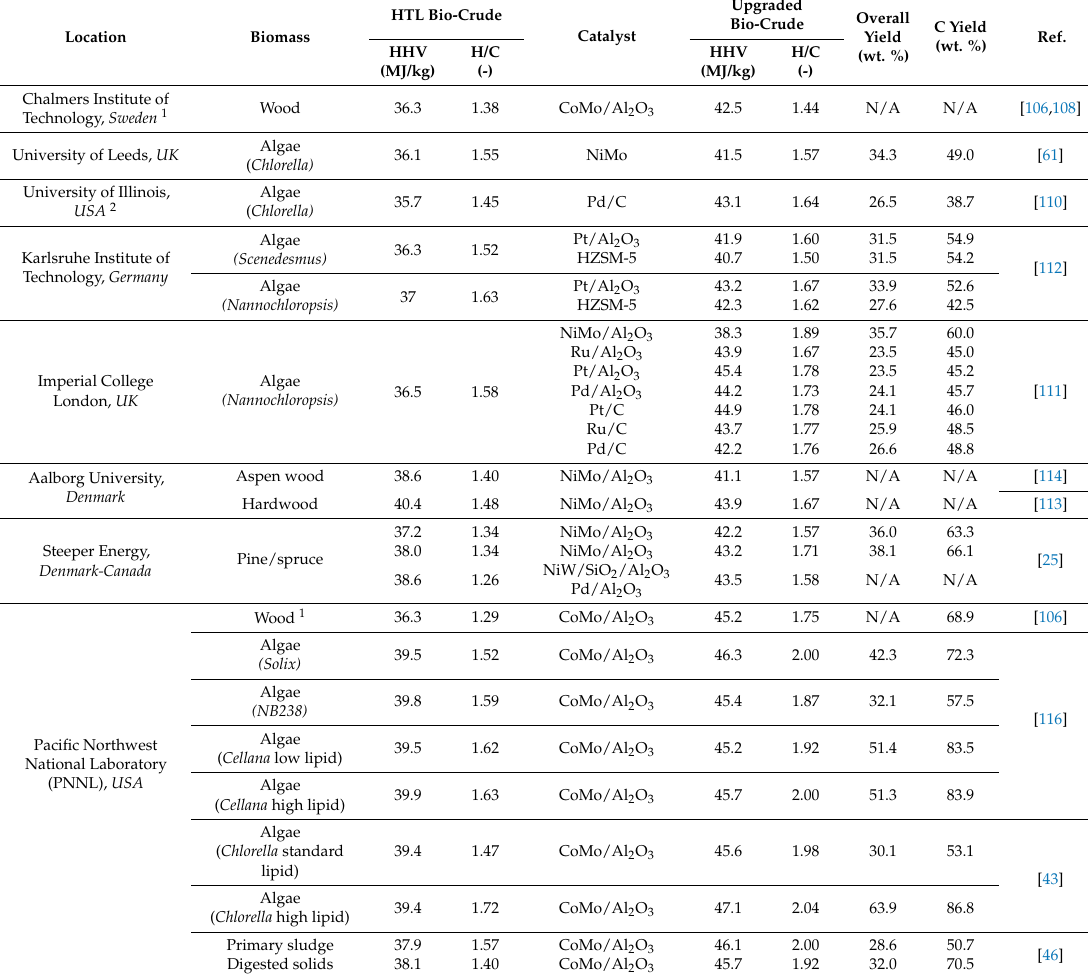
Table 2. Main performance data of the biocrude upgrading studies based on continuous HTL. Location Biomass